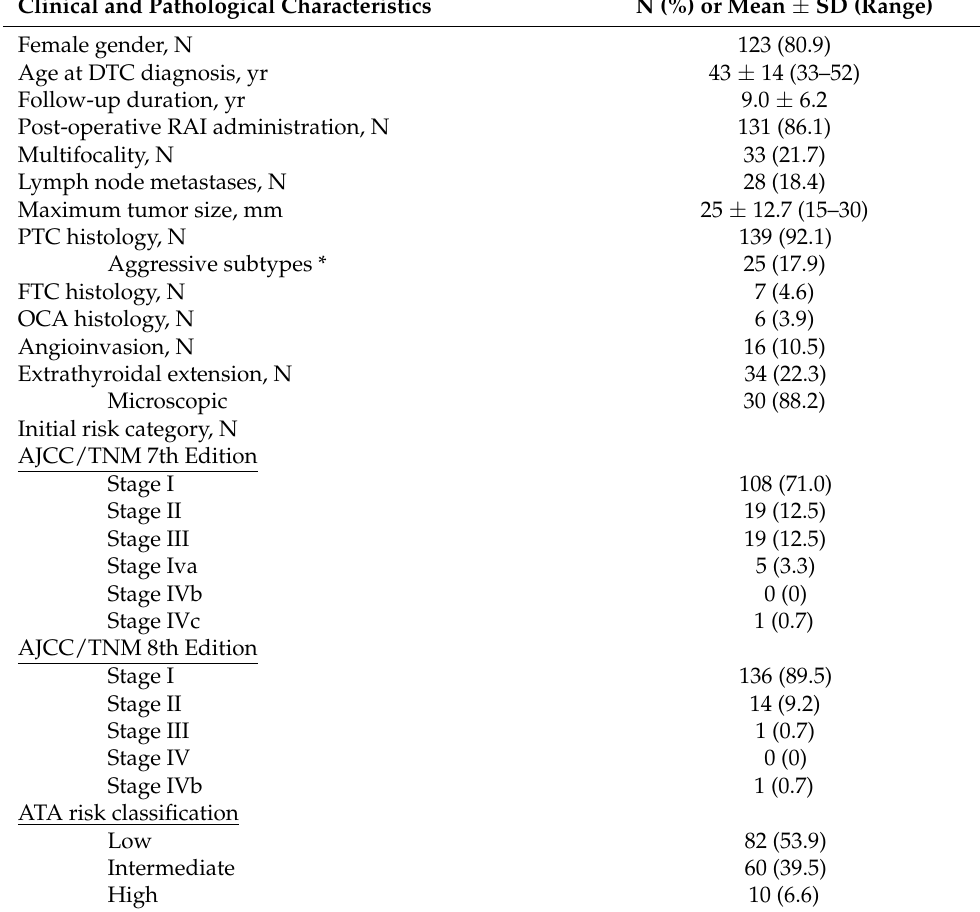
Table 1. Clinical and pathological data of 152 DTC patients submitted to total thyroidectomy with or without post-operative radioiodine (RAI) administration. All patients were followed up for a minimum of 2 years since surgical treatment.